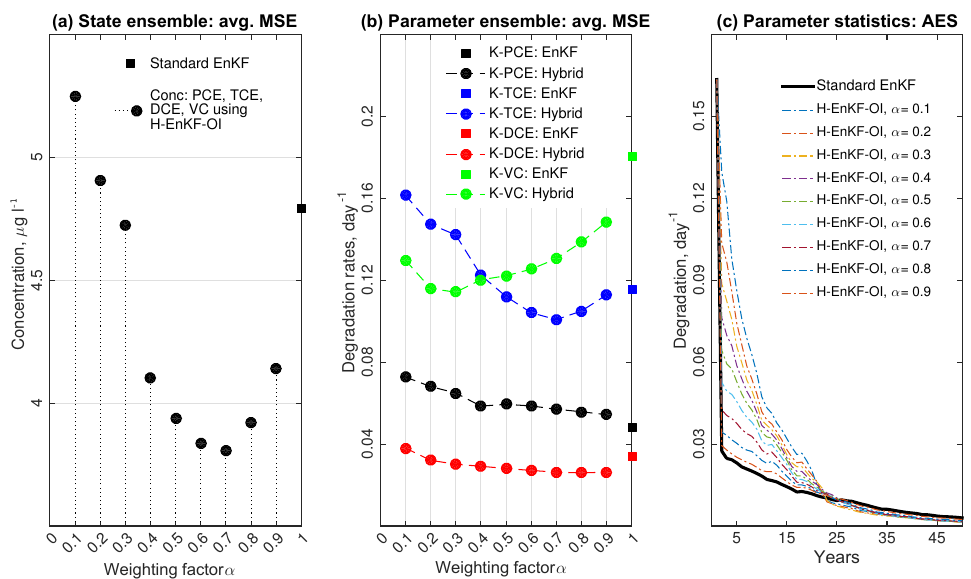
Figure 7. (a) Average mean square errors (MSE) of contaminant concentrations obtained using the EnKF and the hybrid EnKF-OI using α = 0 . 1 , 0 . 2 ,..., 0 . 9. (b) Average MSE for PCE, TCE, DCE and VC biodegradation rates obtained using the EnKF and the hybrid EnKF- OI for different weight factor ( α ) values. (c) Time series change of average ensemble spread (AES) resulting from the EnKF and hybrid EnKF-OI using 48members in which α = 0 . 1 , 0 . 2,..., 0 .